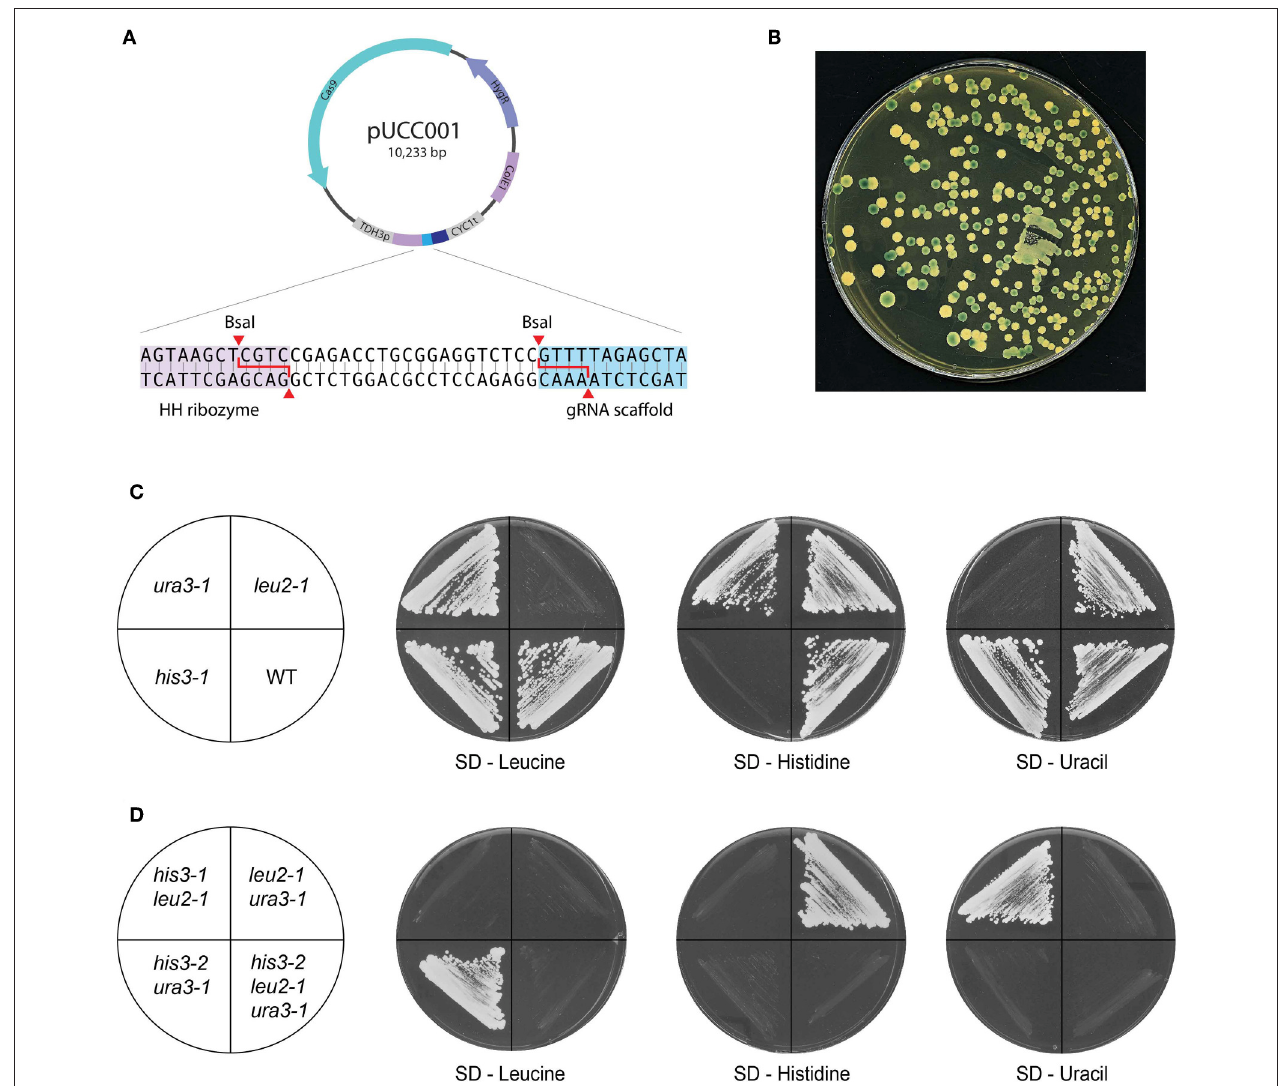
FIGURE 4 | CRISPR/Cas9 genome editing with pUCC001. (A) Map of the plasmid. Based on pUDP002, the plasmid contains Cas9 expressed using the A.adeninivorans promoter, a pangenomic ARS and a gRNA expression cassette under the control of the S. cerevisiae TDH3 promoter. The inset shows the cloning site inserted between the ribozyme units; two BsaI sites allow the construction of new gRNA targets using Golden Gate cloning. (B) Proof-of-principle of pUCC001 function by inactivation of the LAC4 locus. Colonies grown YPGal + X-Gal, with a functioning copy of LAC4 should produce a blue colour on cleaving X-Gal; here, over half of the colonies remain white due to CRISPR-mediated inactivation of LAC4. (C,D) Construction of single and multiple auxotrophs. With pUCC001, we were able to rapidly construct genome editing plasmids targeting orthologues of genes commonly inactivated in S. cerevisiae laboratory strains: URA3, LEU2 and HIS3 , both as (C) single and (D) multiple mutants. Frameshift mutations in each gene created the desired auxotrophies, and the strains so generated could be targeted with other plasmids to create defined double and triple